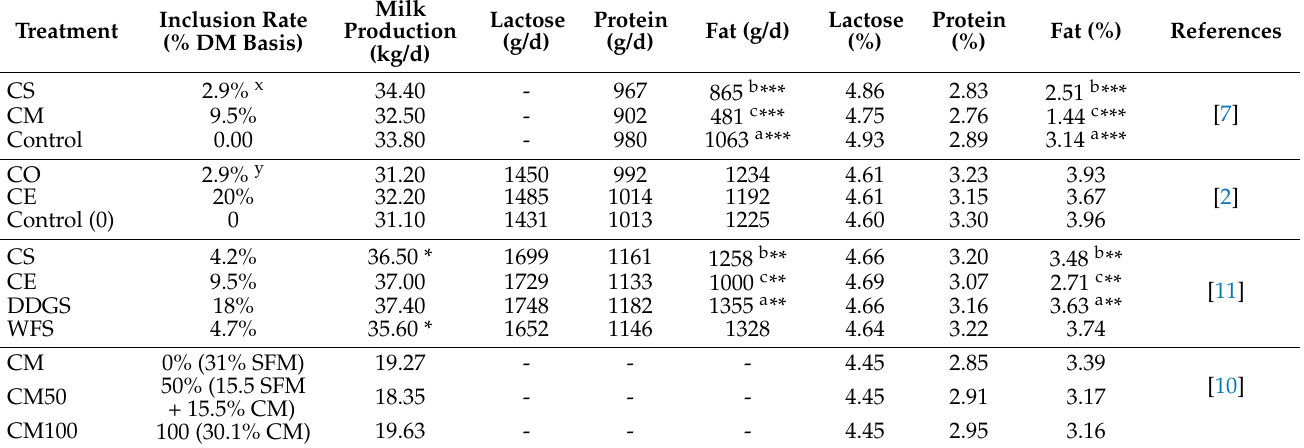
Table 8. Effect of the Camelina seed and its by-products on milk production and composition in dairy cow’s